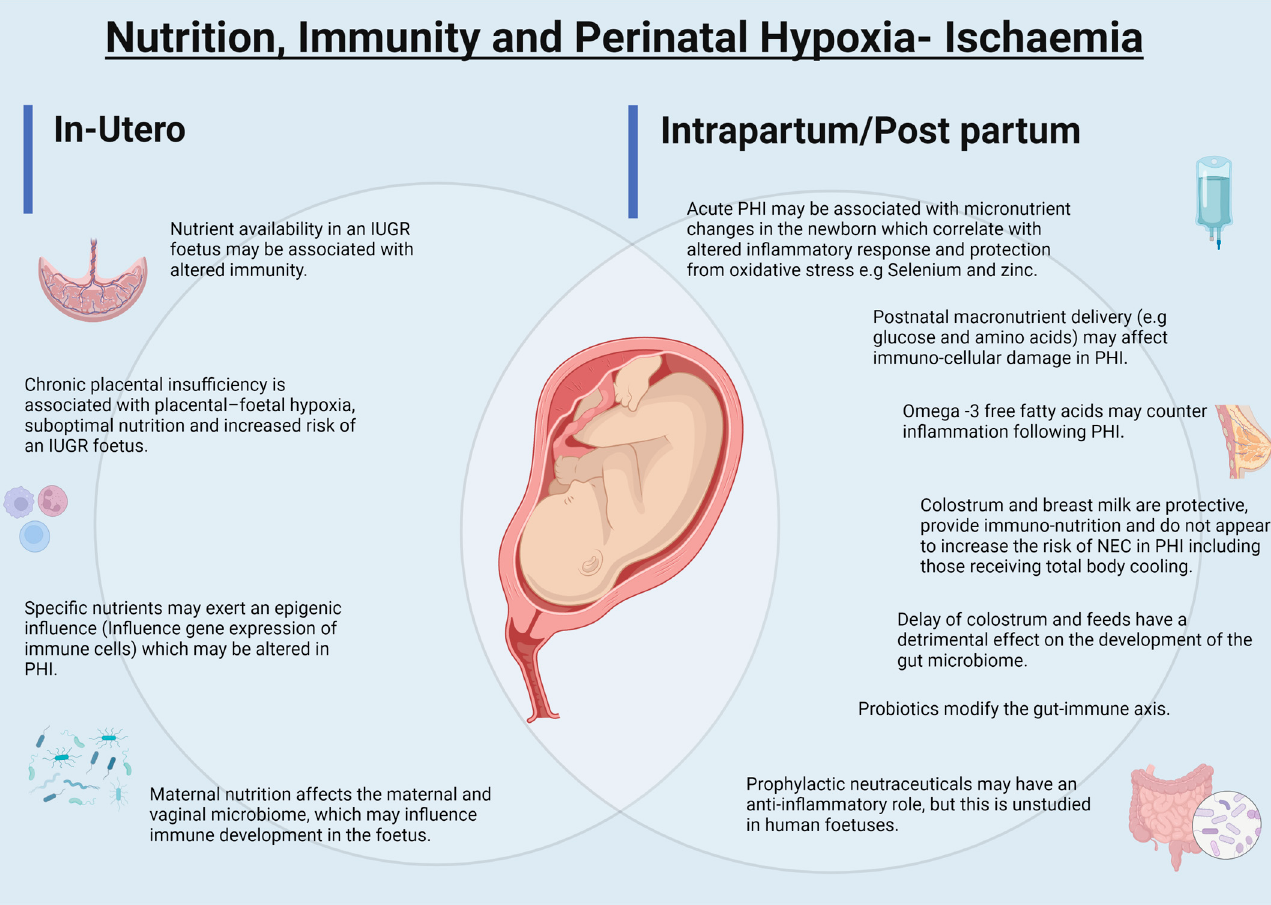
Figure 2. The nutrition–microbiome–immune axis in perinatal hypoxia-ischaemia (PHI): the interrelationship between perinatal nutrition, the maternal, placental and neonatal microbiome, and immunity (altered inflammatory response: injury, protection and repair) in the perinatal (foetal and neonatal) period is illustrated. Image created using Biorender.com (accessed on 29 May 2022).